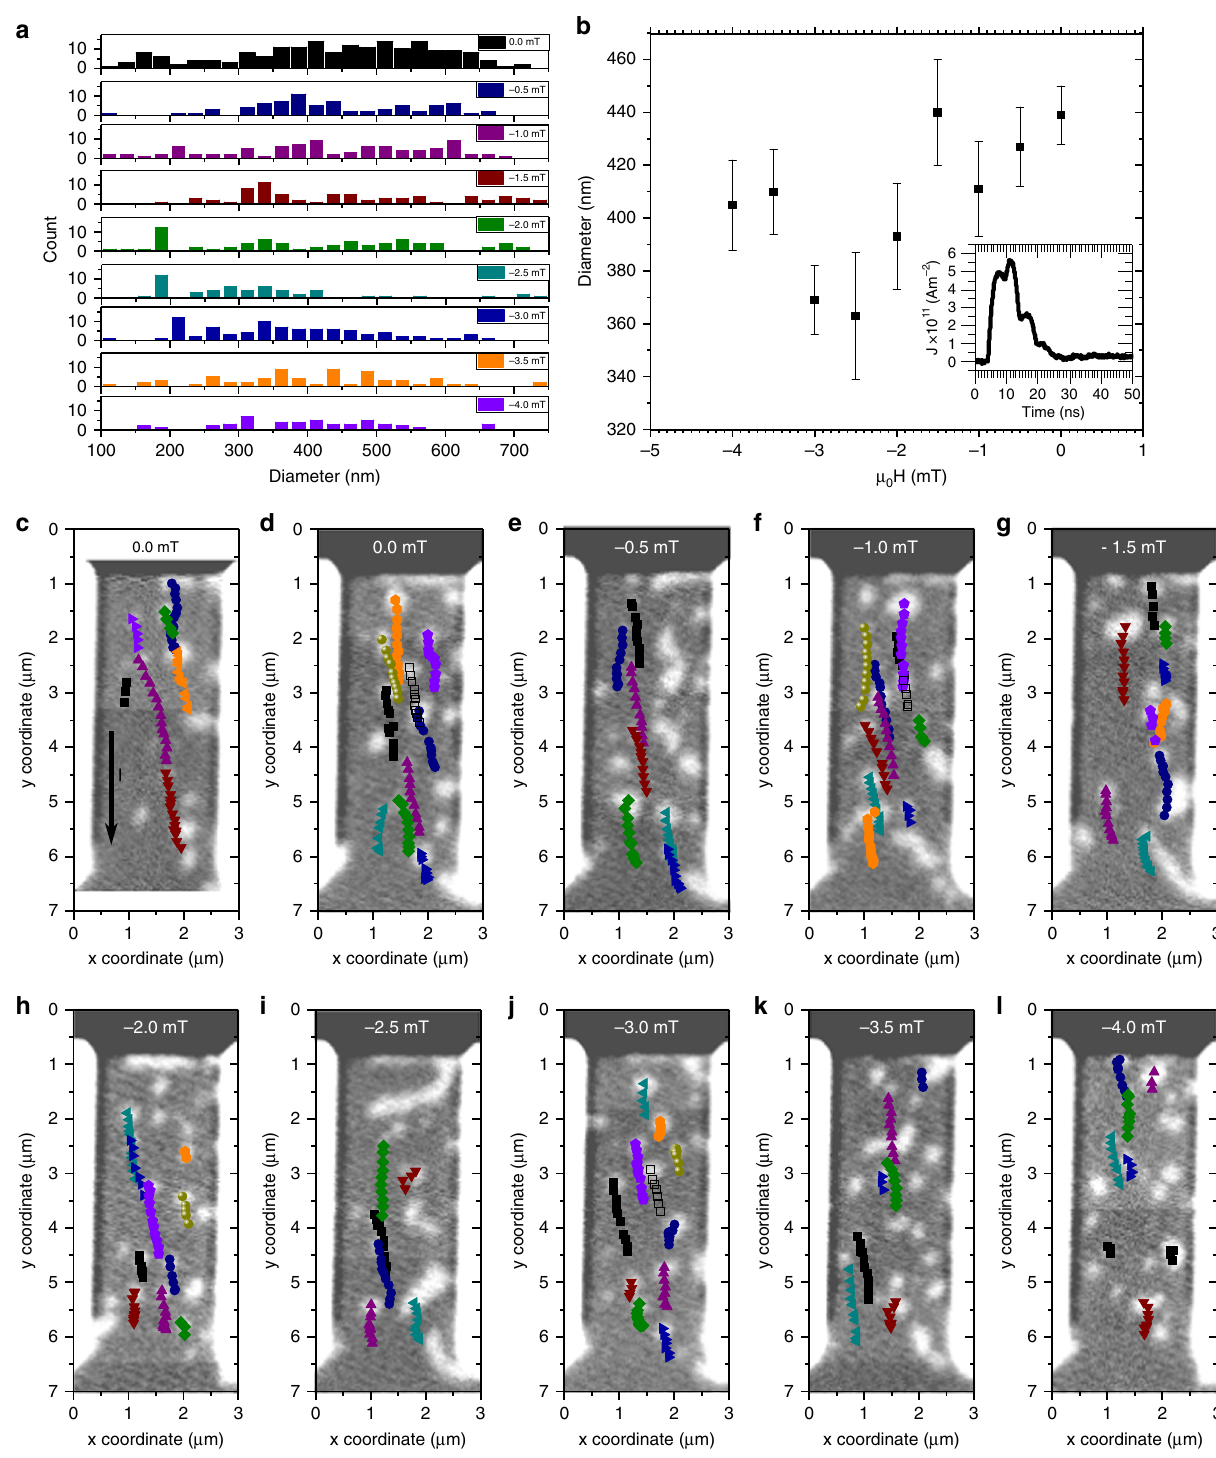
Fig. 2 Current driven skyrmion motion. Applied magnetic fi eld-dependent current-pulse-driven skyrmion motion in 2- μ m-wide Ta/Pt/[Pt/CoB/Ir] ×5 /Pt multilayer wires. a Histogram of the skyrmion diameter distribution at each value of out-of-plane fi eld. b Average diameter at each value of applied fi eld. Standard error is plotted. As the fi eld becomes more negative, the average diameter of the mobile skyrmions reduces until a critical fi eld of − 3 mT, at which point small skyrmions annihilate during the current pulse. The inset shows a trace of the current pulse applied from the top to the bottom of the wire. STXM images taken after two consecutive pulses separated by 2 μ s capturing the skyrmion motion. c – l Initial state STXM single helicity images of the magnetic state in the wire (arrow in c indicates the applied current direction). Superimposed onto the images are the skyrmion centre positions after each two-pulse train (coloured symbols). The images were taken with in an out-of-plane fi eld of 0, 0, − 0.5, − 1.0, − 1.5, − 2.0, − 2.5, − 3.0, − 3.5, − 3.5 and − 4.0 mT, respectively. The peak current density was 5.6 × 10 11 Am − 2